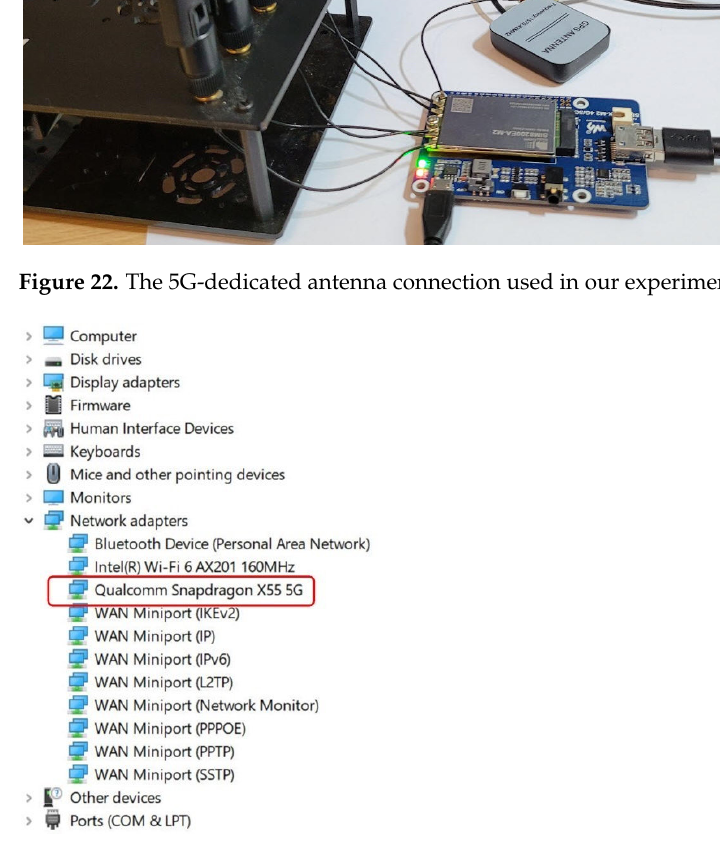
Figure 23. Qualcomm Snapdragon X55 5G project.